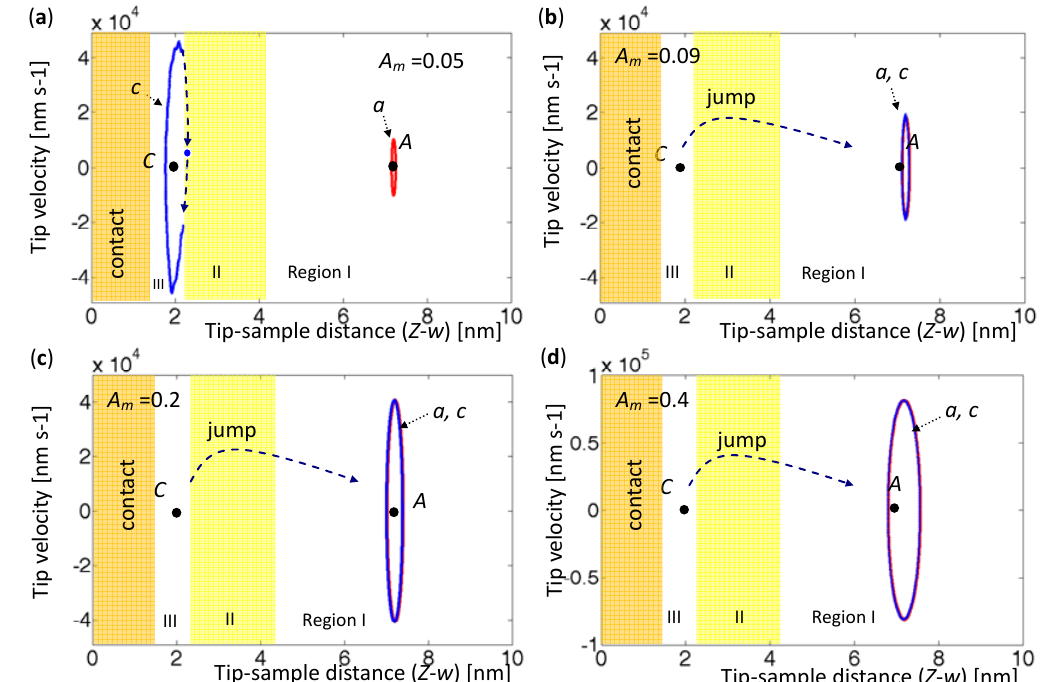
Figure 9. Phase portraits with various driving amplitudes at (cid:2033) (cid:3033)(cid:3004) = 2.12447 × 10 5 rad s − 1 . The orbits marked by ‘ a ’ (red) are driven at Point A ( Z - w = 7.2 nm), and the orbits marked by ‘ c ’ (blue) are driven at Point C ( Z -w = 1.935 nm). ( a ) A = 0.2 nm. ( d ) A = 0.4 nm. ( c ) A m m